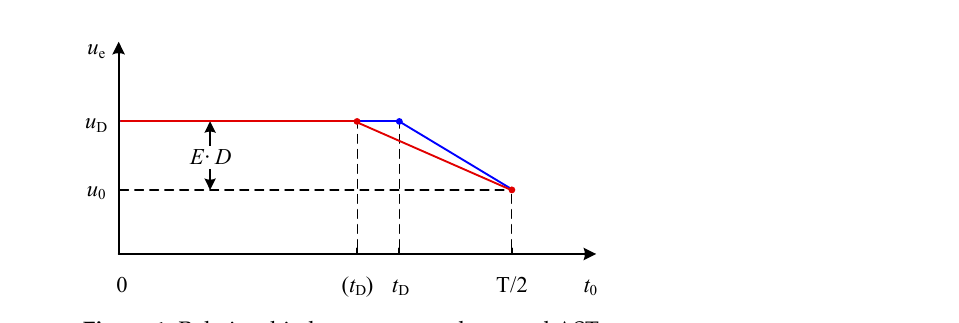
Figure 1. Relationship between arc voltage and AST.